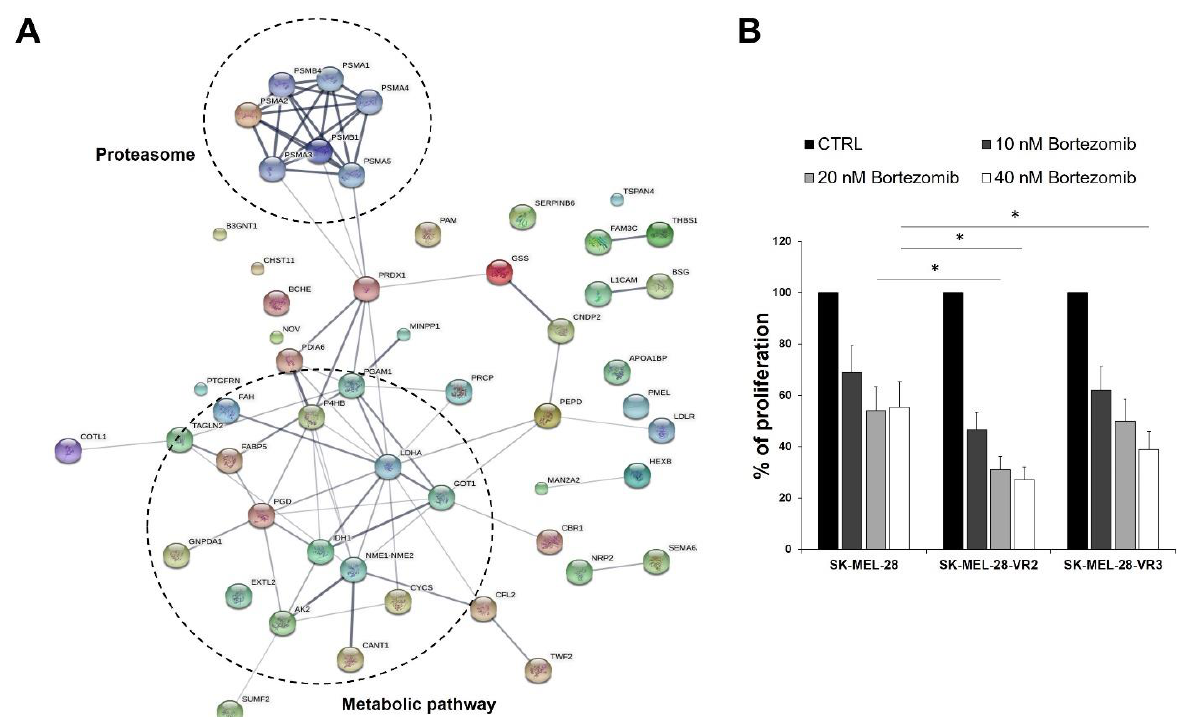
Figure 5. ( A ) The protein–protein interaction network of SK-MEL-28-VR2 differentially expressed proteins as predicted by the STRING software. The links between proteins represent possible interactions (line thickness indicates the strength of association). The two significant pathways were clustered. ( B ) Proliferation rate of melanoma cells left untreated (CTRL) or treated with the proteasome inhibitor bortezomib for 24 h. Data are expressed as % proliferation compared to the CTRL (100%) + SD of three independent experiments (statistical significance: * p < 0.01).